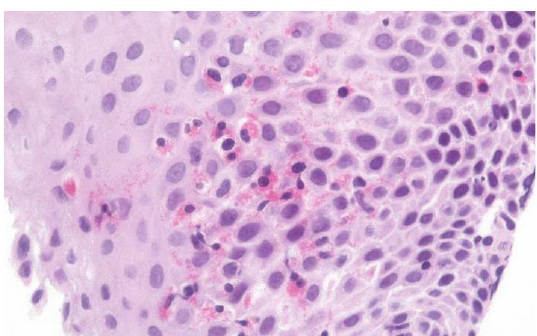
Figure 1: Haematoxylin- and eosin-(H+E) stained slide of oesophageal biopsy. Note the infiltration and clustering of eosinophils, characterized by their bright red cytoplasmic